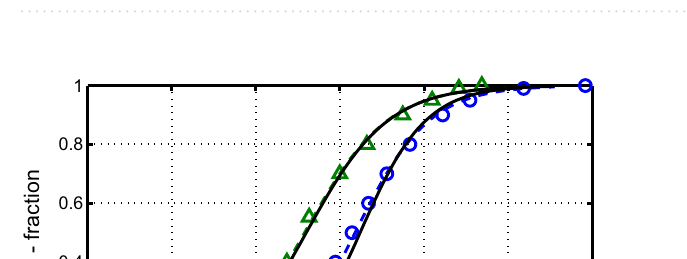
Table 3. Model B parameter constants, Eqs. (11)–(13).